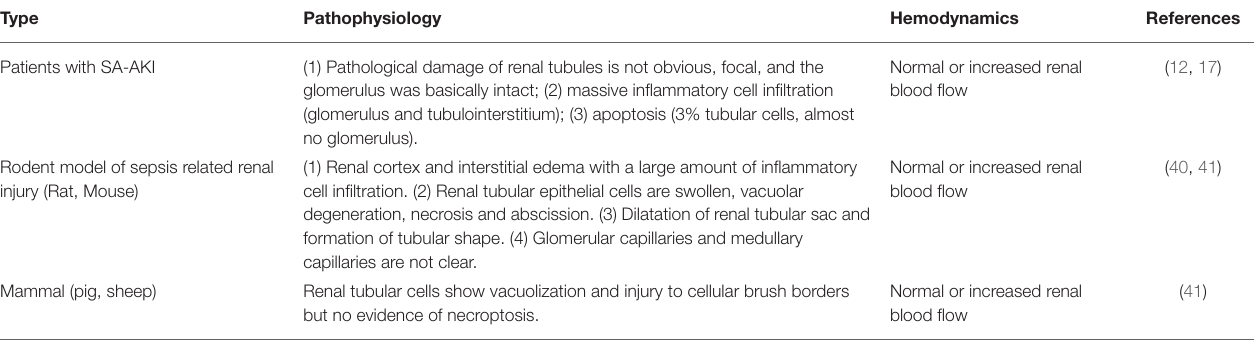
TABLE 1 | Modes of sepsis-associated acute kidney